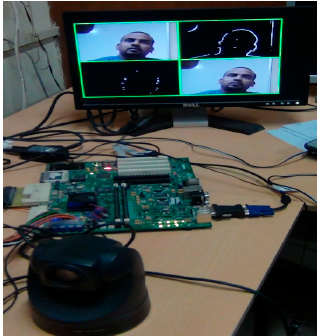
Figure 21. Complete motion detection system setup.